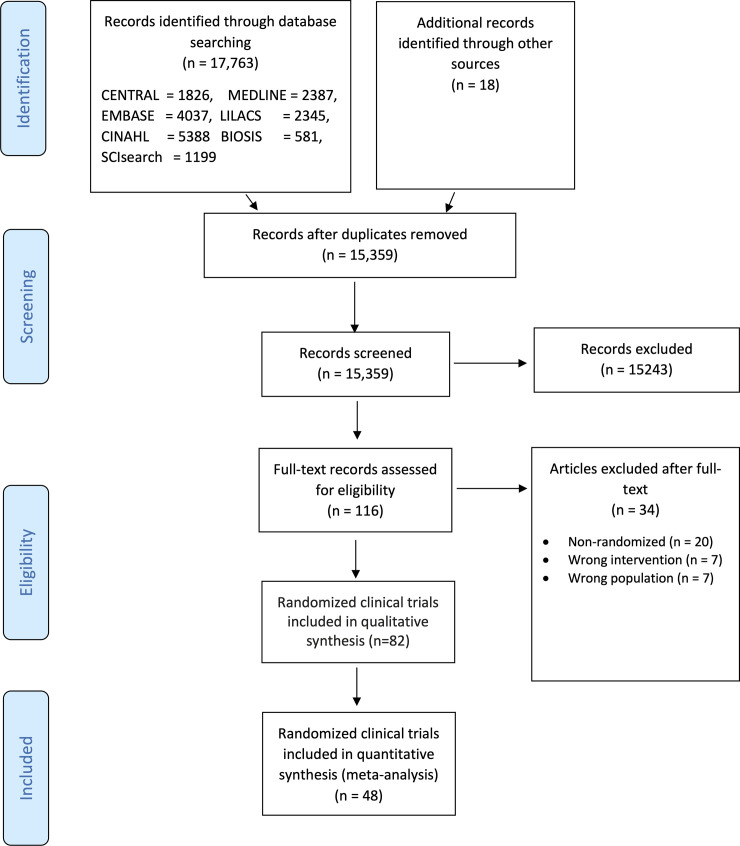
PRISMA flow diagram.